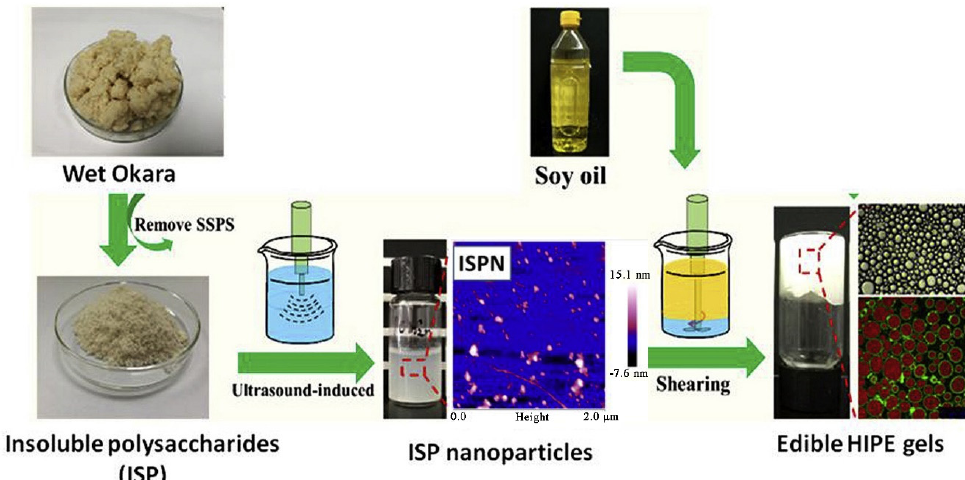
Figure 5. Synthesis of ultrasound-induced insoluble soy polysaccharide (ISP) based nanoparticles for developing and edible O/W high internal phase Pickering emulsion gels [60].